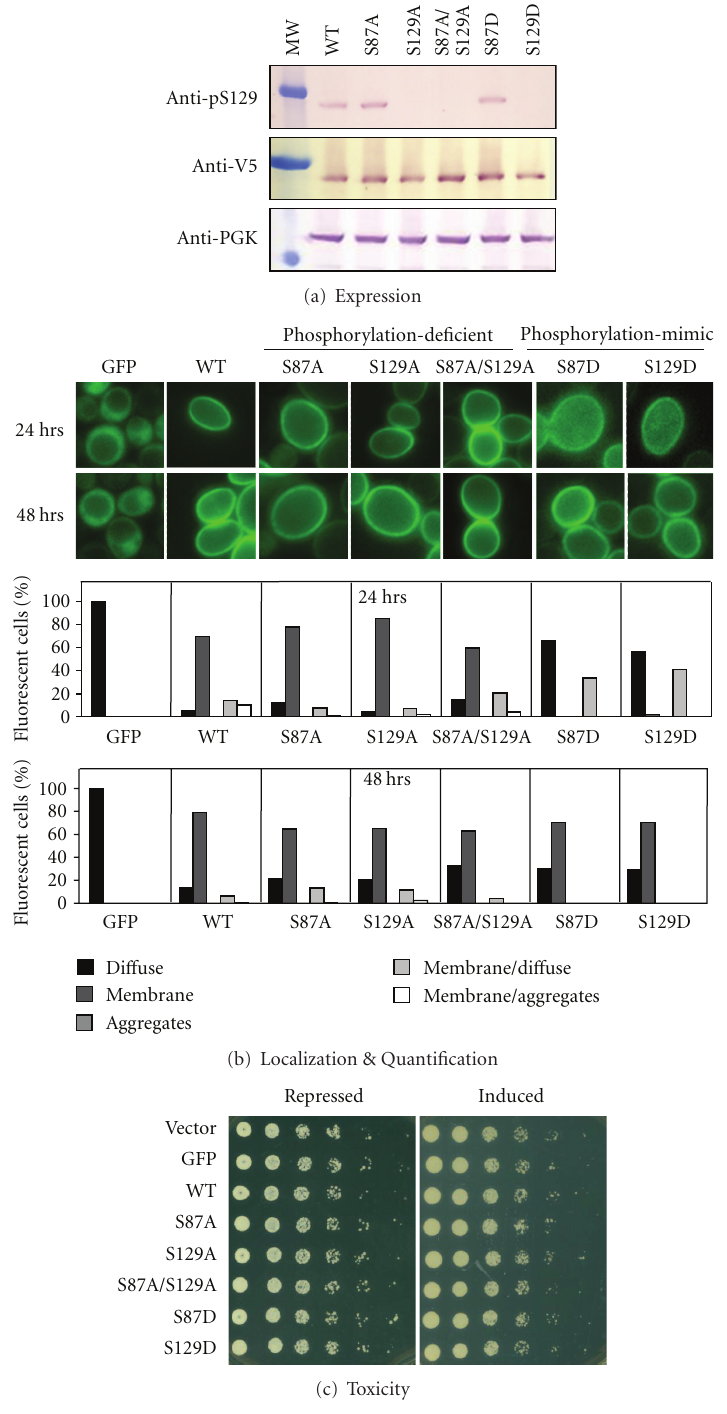
Figure 3: Characterization of phosphorylation mutants in BY4741. (a) Western blot of WT, phosphorylation-deficient mutants (S87A, S129A, and S87A/S129A), and phosphorylation-mimic mutants (S87D, S129D). BY4741 lysates were probed with anti-pS129 (top), anti- V5 ( α -synuclein; middle), and anti-PGK, which served as a protein-loading control (bottom). WT, S87A, and S87D are phosphorylated at serine-129 ( N = 2). (b) Live-cell GFP microscopy of BY4741 cells expressing GFP, WT, S87A, S129A, S87A/S129A, S87D, or S129D at 24 and 48 hours ( top ). Quantification: ∼ 750 cells of each type were scored for these localization patterns: cytoplasmically di ff use, and plasma membrane, aggregate, plasma membrane/di ff use, plasma membrane/aggregate ( bottom ). Phenotypes were plotted as a percent of total cells that fluoresced ( N = 2). (c) Cells expressing WT, S87A, S129A, S87A/S129A, S87D, or S129D were grown in inducing (galactose) media for 48 hours. Vector alone and GFP served as controls. Equal number of cells were serially diluted 5-fold and spotted onto repressing (glucose) or inducing (galactose) plates and grown for two days ( bottom ). No phosphorylation-specific toxicity was apparent ( N =